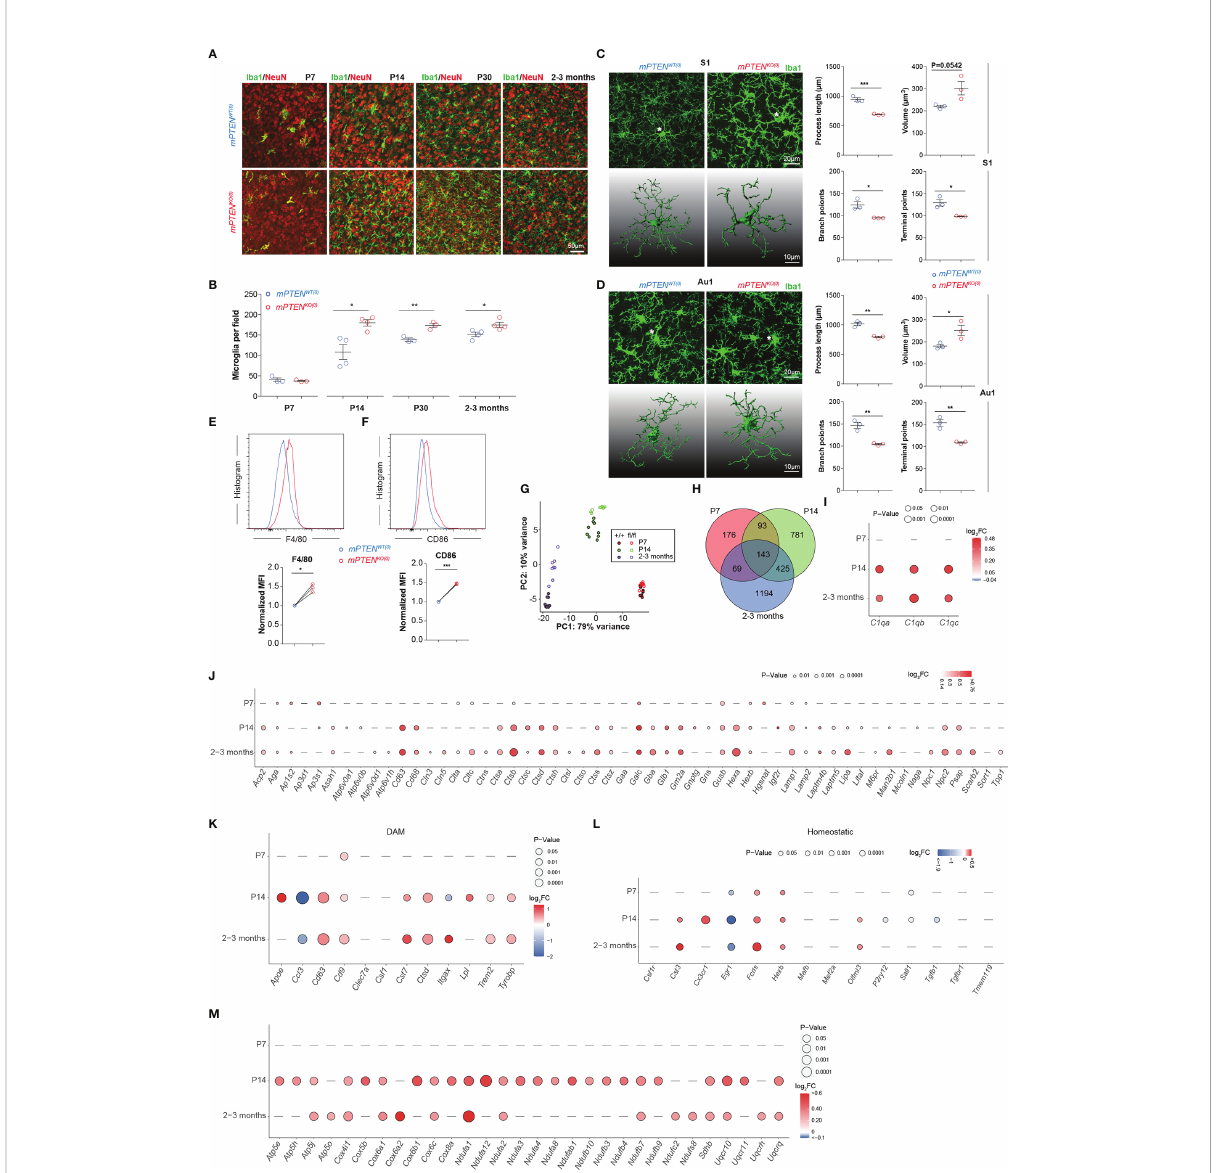
FIGURE 2 Microglia phenotypes after postnatal Pten ablation. (A) Representative images of Iba1-stained microglia (green) in the context of NeuN staining (red) in the somatosensory cortex (coronal sections) of mPTEN WT(0) and mPTEN KO(0) mice at indicated time points. (B) Numbers of Iba1 + microglia per fi eld (0.4 mm 2 ), as quanti fi ed from (A) . Each dot represents a mouse (microglia quantitated in n=5-10 fi elds per mouse), and lines denote mean±s.e.m. (P7, P14, P30, and 2-3 months, N=3, 4, 3, 3 mice). (C) Left, maximum intensity projection images (top) and 3-D reconstruction of the asterisked microglia (bottom) from the somatosensory cortex (S1) of 2- to 3-month-old mice, mPTEN WT(0) or mPTEN KO(0) as indicated; Right, automated morphometric analyses of microglial process length, volume, number of branch points, and number of dendrite terminal points. Each dot represents a mouse (5-10 cells per mouse), and lines denote mean±s.e.m. of individual mice. (D) Microglia from the auditory (Au1) cortex, analyzed and presented exactly as in (C) . (E, F) Representative histograms (top) and normalized MFI (bottom) of F4/80 (E) and CD86 (F) staining of mPTEN WT(0) and mPTEN KO(0) microglia (2- to 3-month-old mice). Each pair of line-connected dots represents one of the three independent experiments conducted. In each experiment, microglia of each genotype were pooled from 2 mice. * P < 0.05, ** P < 0.01, *** P < 0.001 by unpaired t test (B-F) . (G) Transcriptomic PCA analyses of sort-puri fi ed cortical microglia from P7, P14 and 2-3 months. (H) Venn diagram of DEGs between wildtype and PTEN-ablated microglia at P7, P14 to 2-3 months. (I) A bubble plot showing differential expression of indicated complement genes (X axis) at indicated time points (Y axis). Bubble color, Log 2 FC=Log 2 (mPTEN KO(0) /mPTEN WT(0) ); bubble size, levels of statistical signi fi cance de fi ned by P values; a dash indicates no signi fi cant difference observed. (J) A bubble plot showing differential expression of lysosome-related genes at indicated time points, formatted as in (I) . (K, L) A bubble plot showing differential expression of indicated DAM (K) and homeostatic (L) genes, formatted as in (I) . (M) A bubble plot showing differential expression of indicated mitochondria- related genes, formatted as in (I)